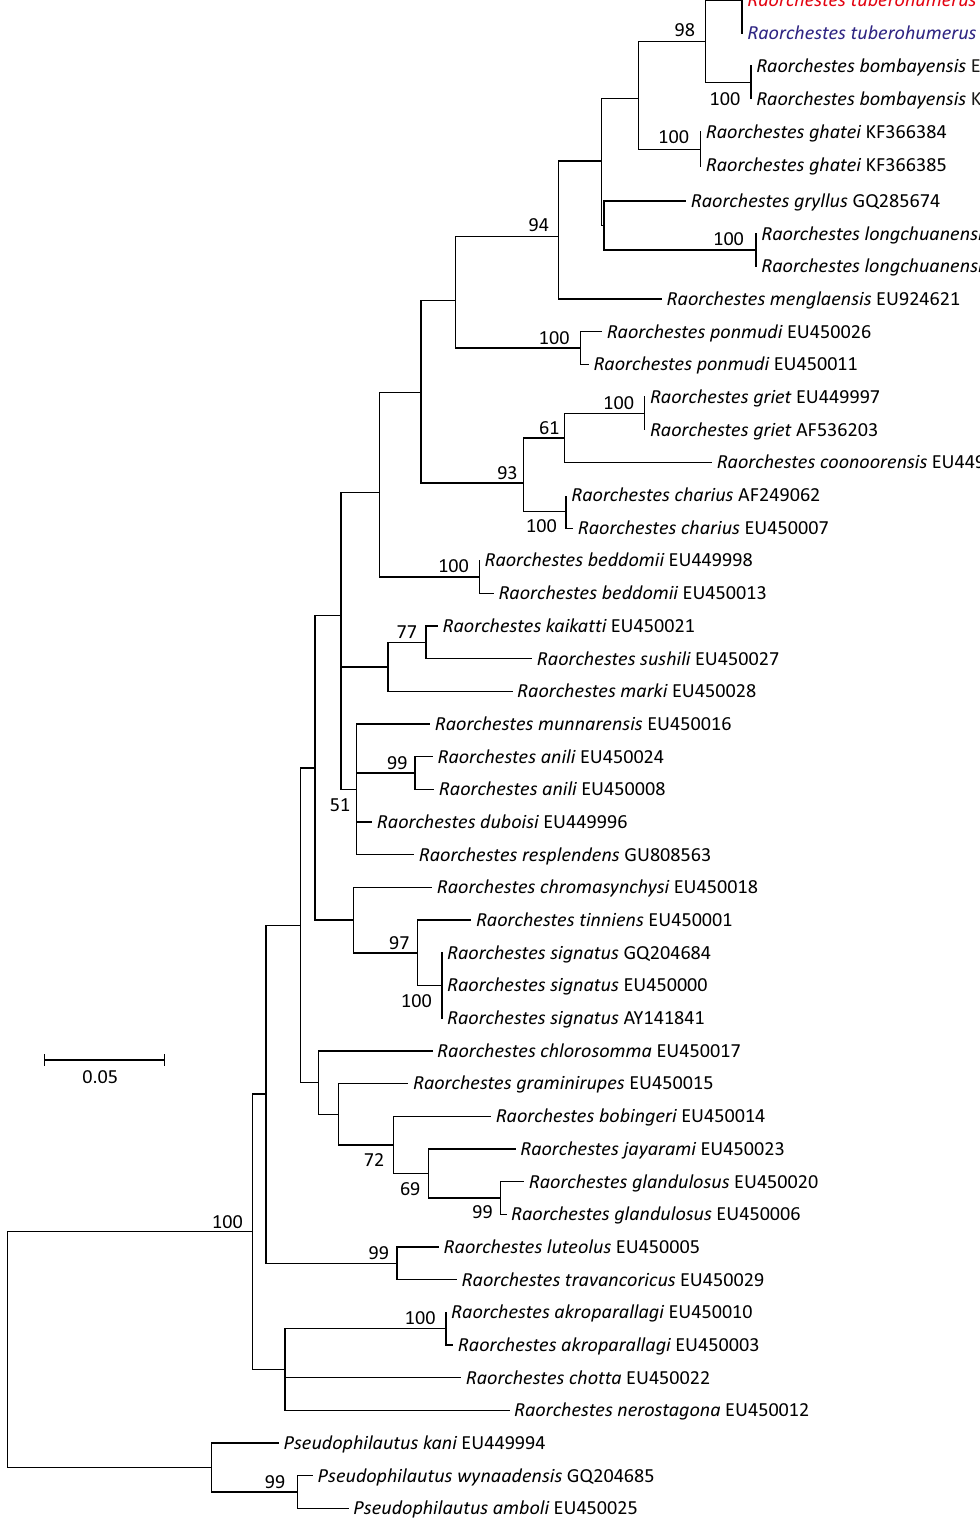
Figure 1. Maximum likelihood tree based on 16S rRNA gene using general time reversal with gamma distribution and invariant sites (GTR+G+I, BIC = 7197.32, lnL = -2961.16, I = 0.44, G = 0.46) model of nucleotide substitution. Percent bootstrap values are for 1000